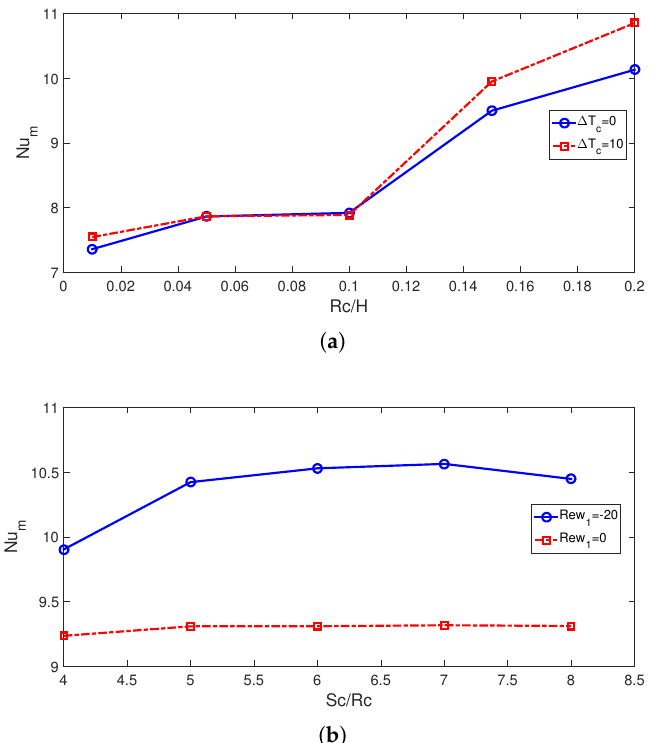
Figure 7. Effects of RCC size (Sc = 6Rc, ( a )) and distance between the cylinders (Rc = 0.1H, ( b )) on the average Nu variations ( ( Rew 1 ,Rew 2 ) = ( − 20, − 20 ) , ∆ T = 10, SVF = 3%).